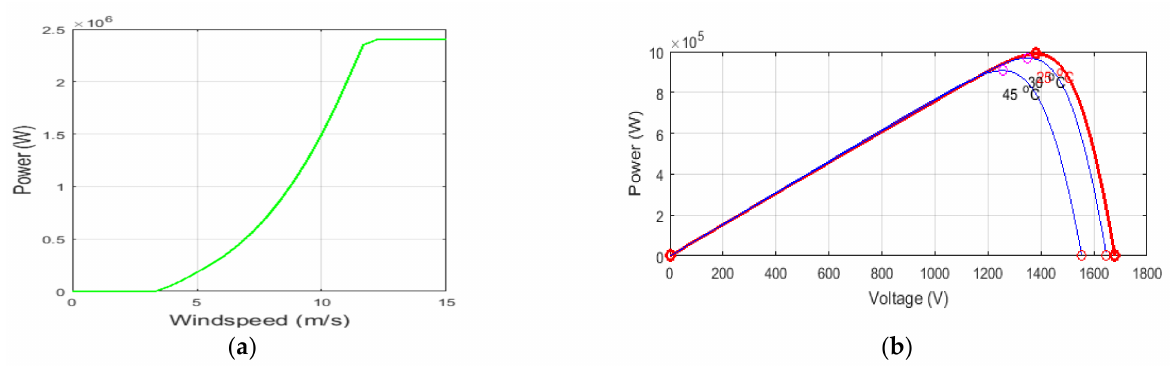
Figure 18. Characteristics of hybrid system: ( a ) wind power curve; ( b ) PV